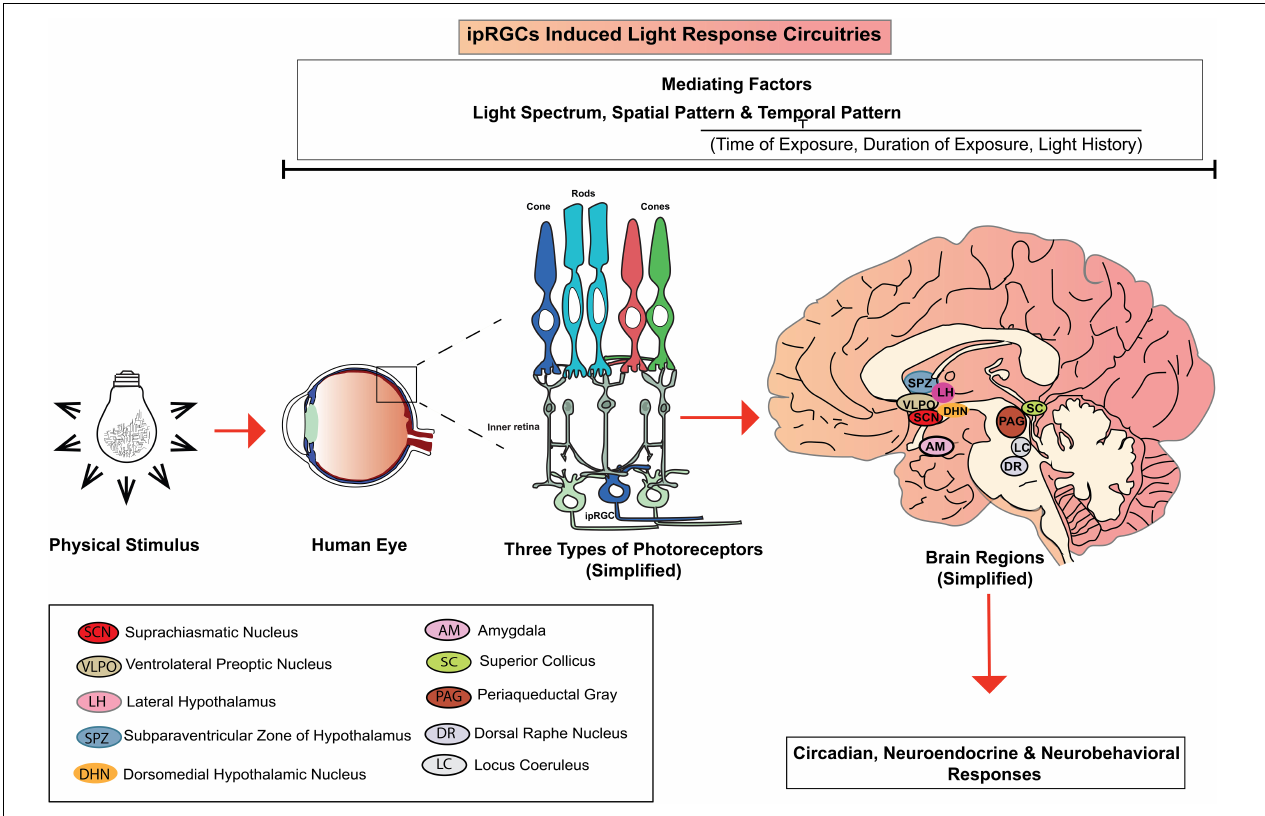
FIGURE 2 | IpRGCs induced light response